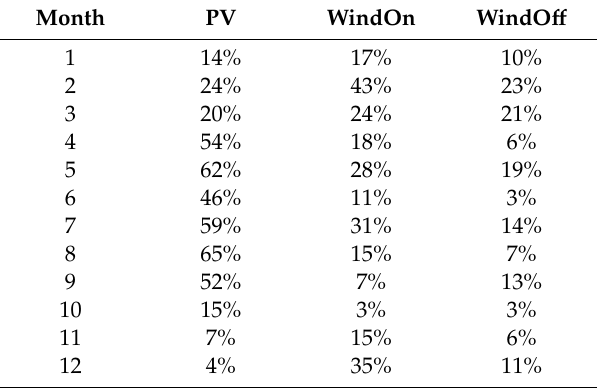
Table 3. Technology-specific share of monthly sold energy in hours when variable renewable energies (VREs) are price setting compared to monthly total of sold energy by that technology.